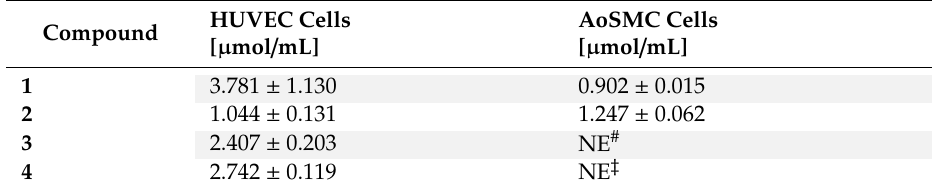
Table 1. The e ff ects of metformin derivatives on HUVEC and AoSMC cell growth. The results (IC 50 values, µ mol / mL) are presented as mean ± SD ( n =